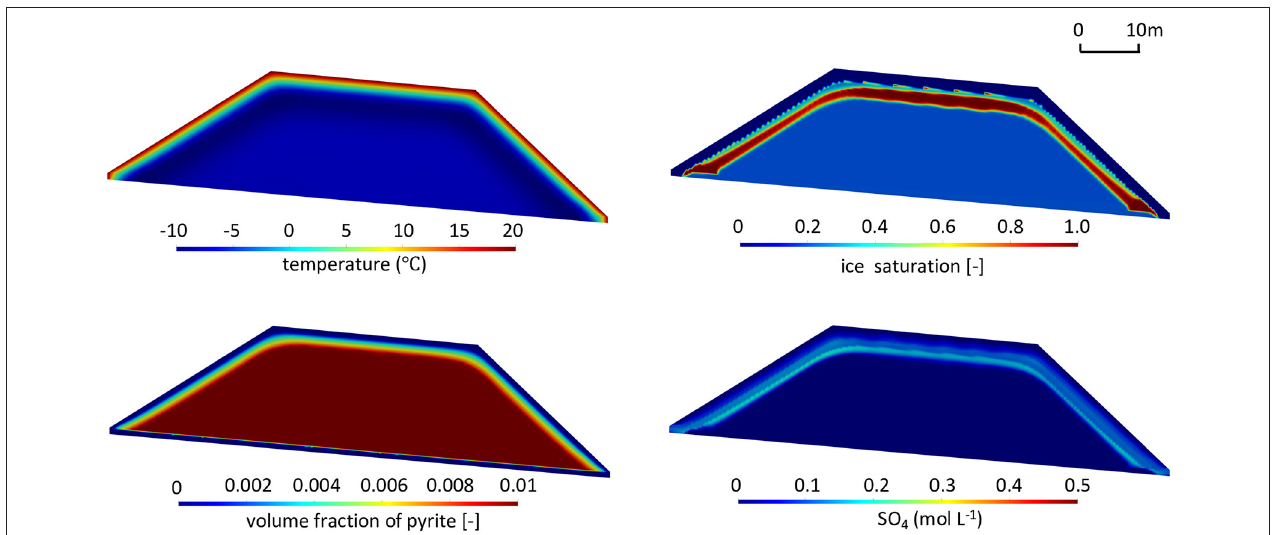
Frontiers in Water |